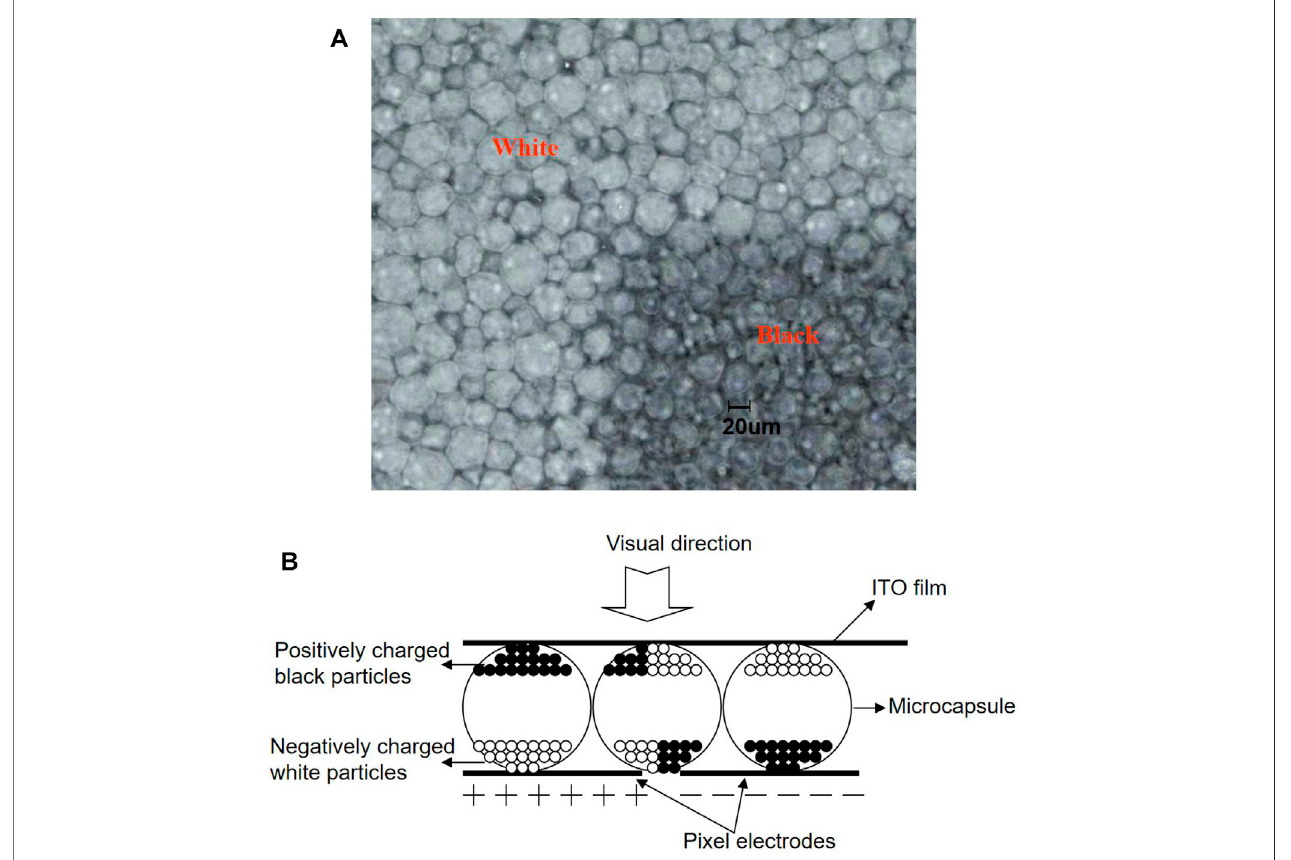
FIGURE 1 | The structure of a microcapsule EPD. (A) An enlargement image of microcapsules in an EPD. (B) EPD model.